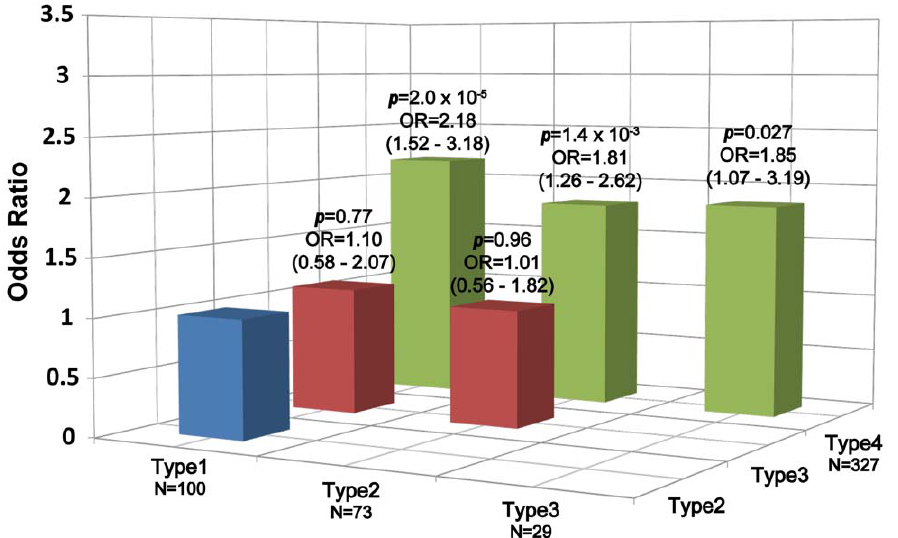
Figure 3. Histogram of odds ratios for genotype distribution of rs738409 between Matteoni types. Each box denotes the odds ratio (OR) comparing the corresponding Matteoni types on the horizontal axes. N represents the number of samples. Odds ratios and p -values are calculated for the higher Matteoni type per risk allele (G) on additive model by multivariable logistic regression adjusted for age, sex and BMI, and are shown with 95% CI above each box.